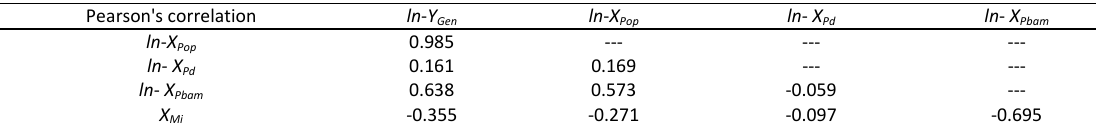
Table 4: Correlation matrix of variables